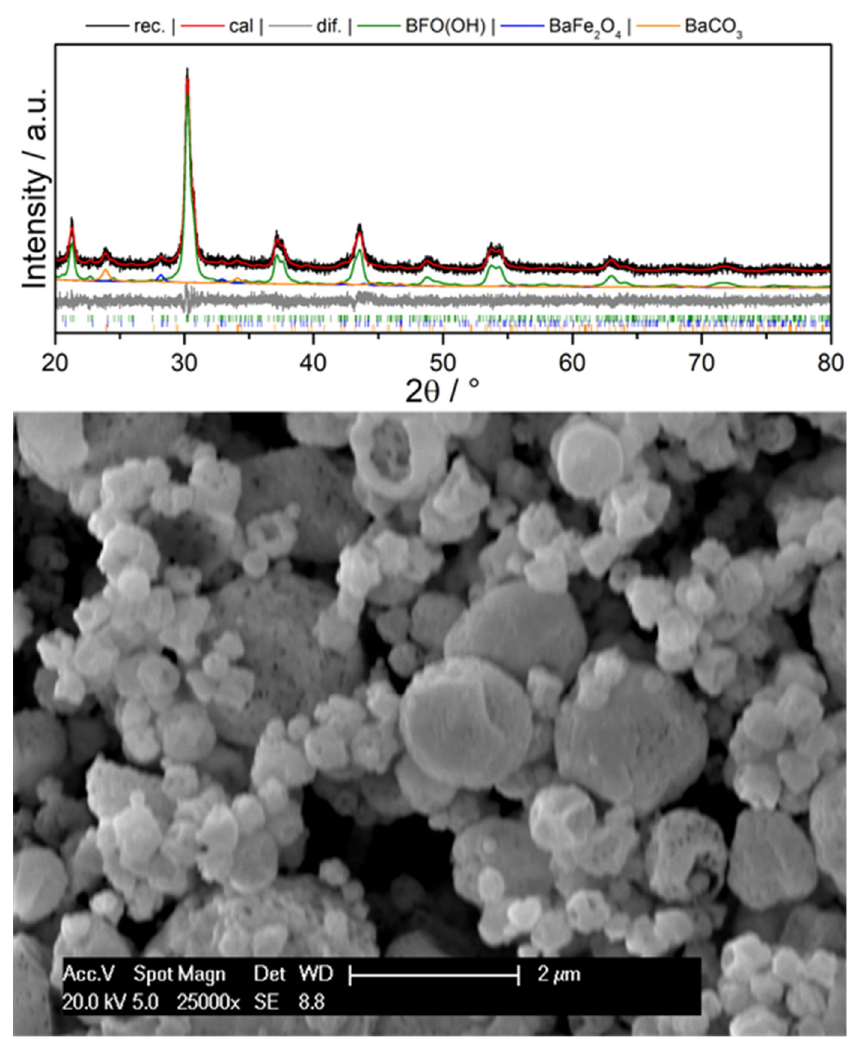
Figure 7. XRD pattern of as-synthesized water-containing BFO and SEM micrograph of the dried BFO.